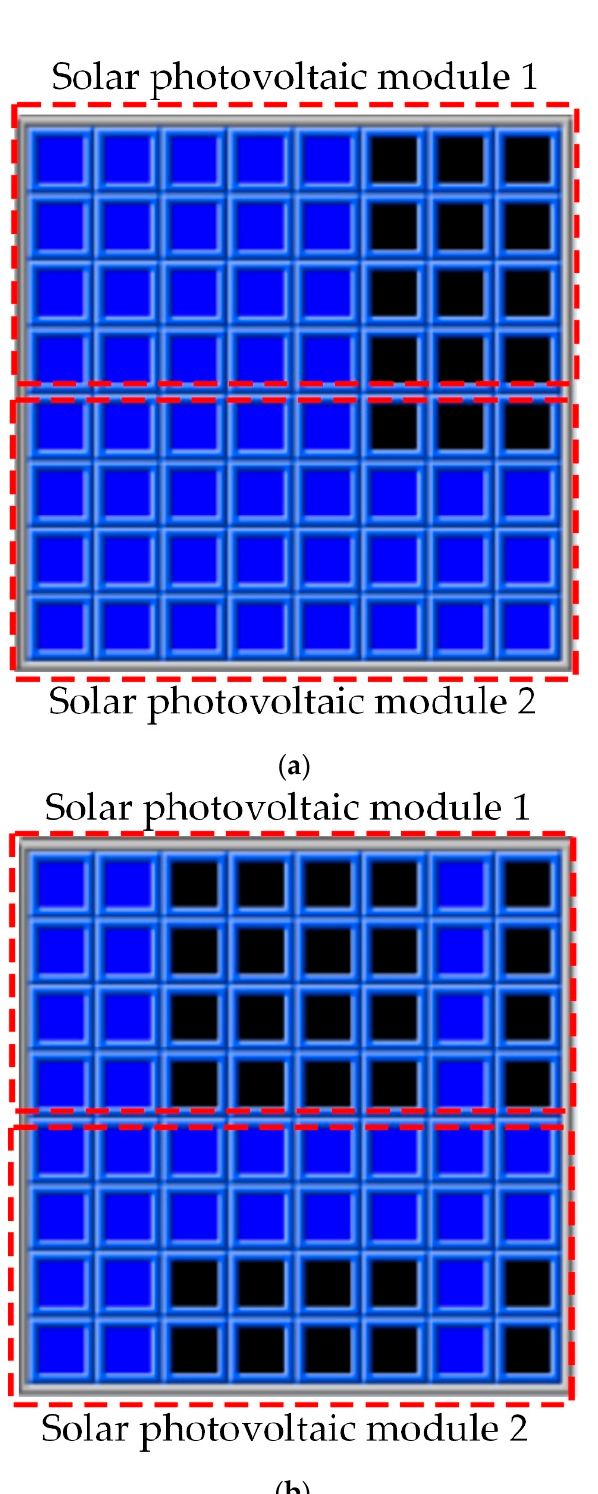
Figure 17. Schematic diagram of the two SPVMs connected in series performing the shadow simulation in the solar photovoltaic simulator at ( a ) IL = 700 W/m 2 and temperature = 25 °C and ( b ) IL = 65 W/m 2 and temperature = 25 °C.